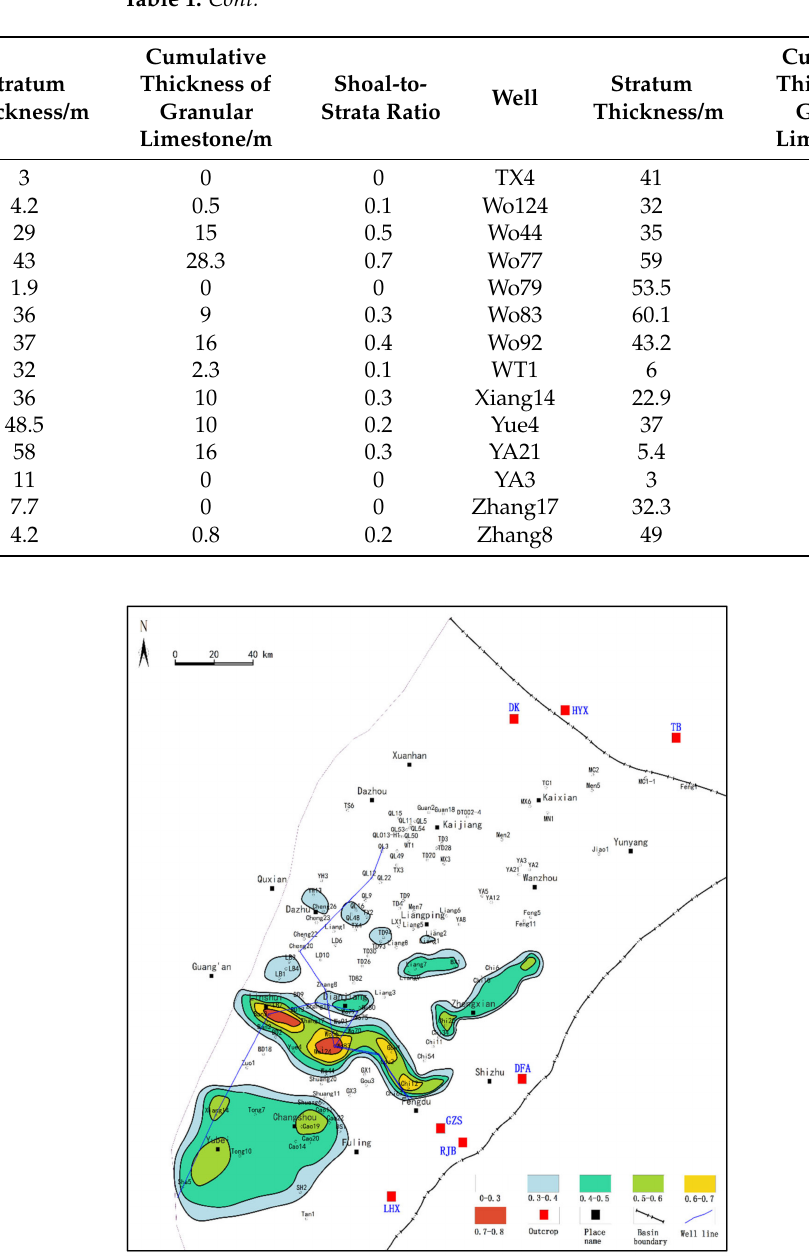
Figure 13. Planar distribution of shoal-to-strata ratio in the P 2 m 2